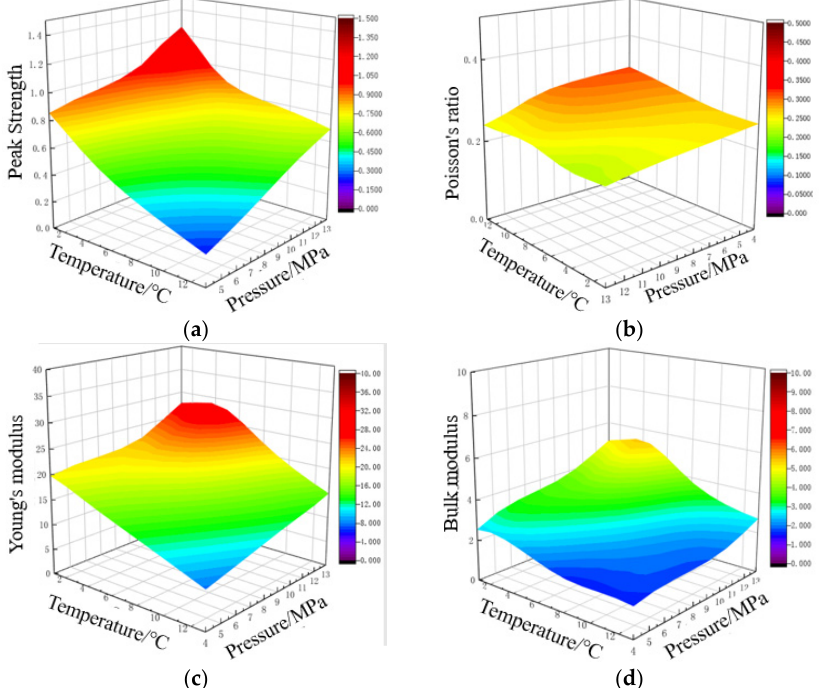
Figure 15. Variation of mechanical properties of muddy silt hydrate with temperature and pressure ( a ) Peak Strength; ( b ) Poisson’s ratio; ( c ) Young’s modulus; ( d ) Bulk modulus. When the saturation/mass abundance is constant, the peak core strength tends to de- crease with increasing temperature and lowering pressure, as demonstrated by the com- parisons above. Under experimental settings, the peak strength of sandy hydrate varies between 6.9 and 13.1 MPa, whereas the peak strength of muddy silt hydrate varies be- tween 0.77 and 1.5 MPa. Temperature and pressure have a bigger impact on the elastic modulus than Poisson’s ratio. Under experimental conditions, Poisson’s ratio of sandy hydrate ranged between 0.12 and 0.18, and Poisson’s ratio of muddy silt hydrate ranged